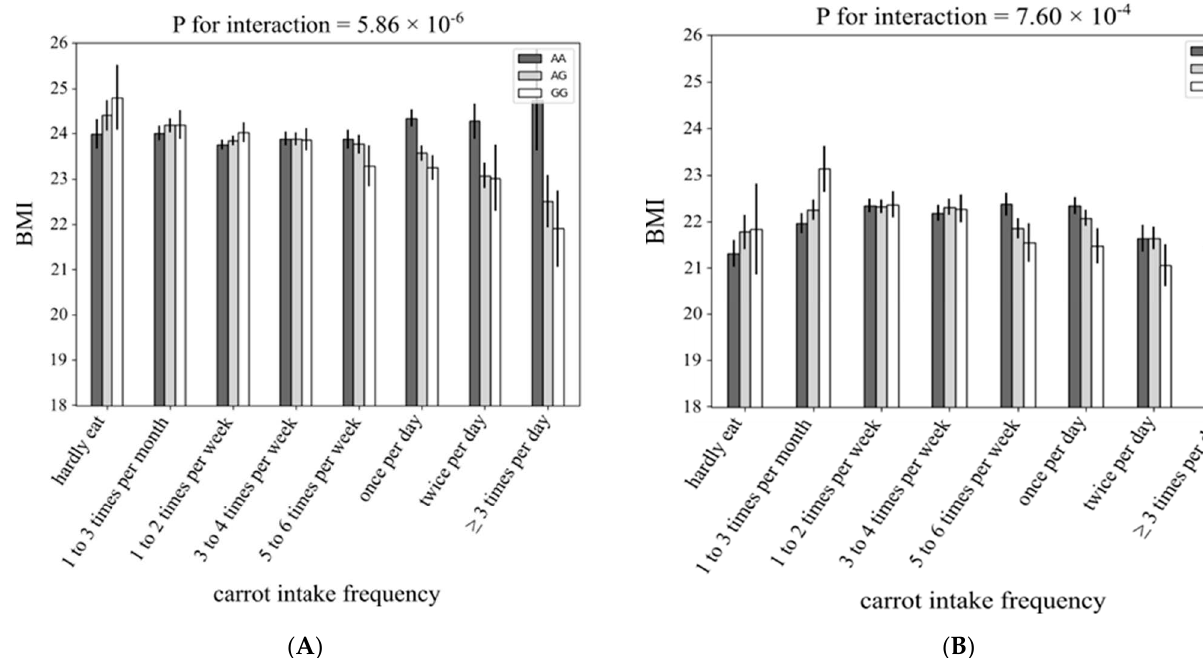
Figure 4. The association between each rs4445711 allele and frequency of carrot intake: subgroup analysis stratified by sex. The y -axis represents body mass index according to the genotype of the lead variant at rs4445711—i.e., GG, AG, or AA—and the x -axis shows the 8 categories of carrot intake frequency, ( A ) male, and ( B ) female.